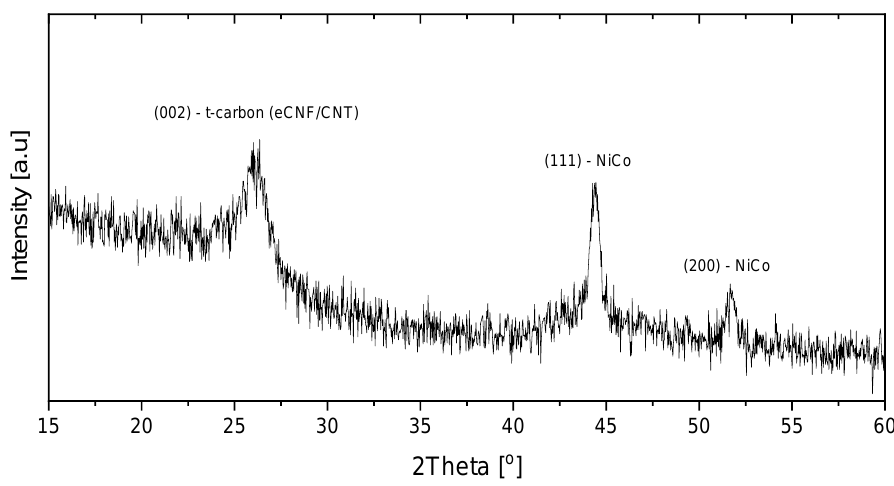
Figure 2. X-ray diffraction pattern of eCNF/CNT/NiCo nanocomposite.